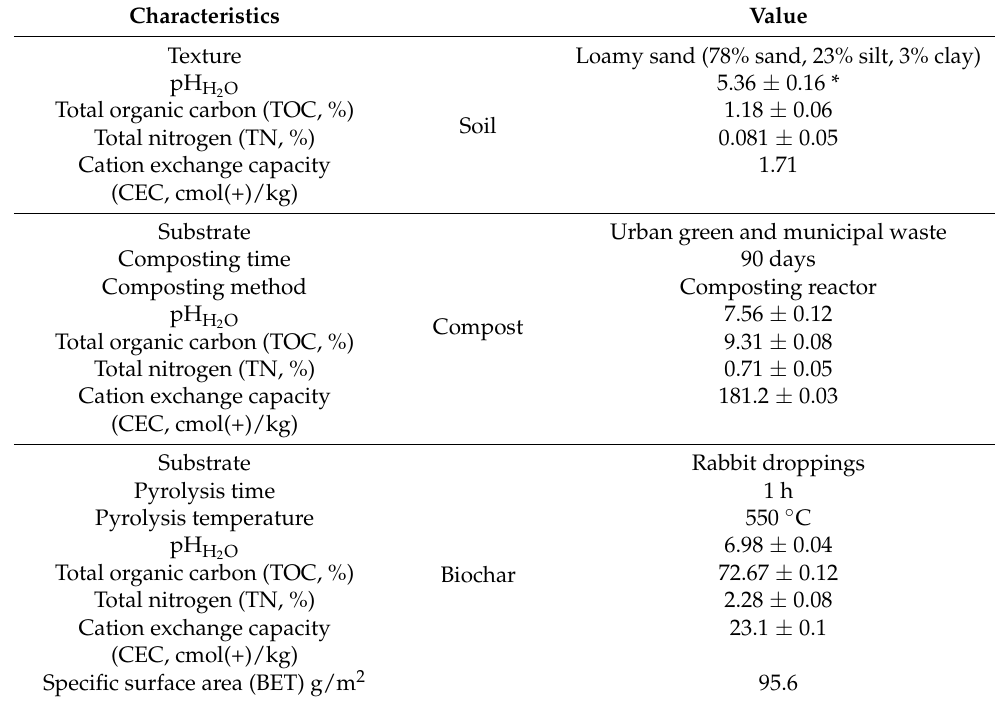
Table 1. Properties of soil, biochar and compost used in the